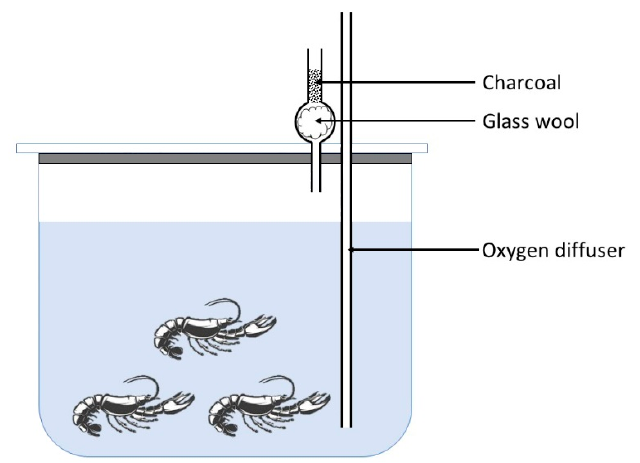
Figure 1. Scheme of 15-liters exposure tank.